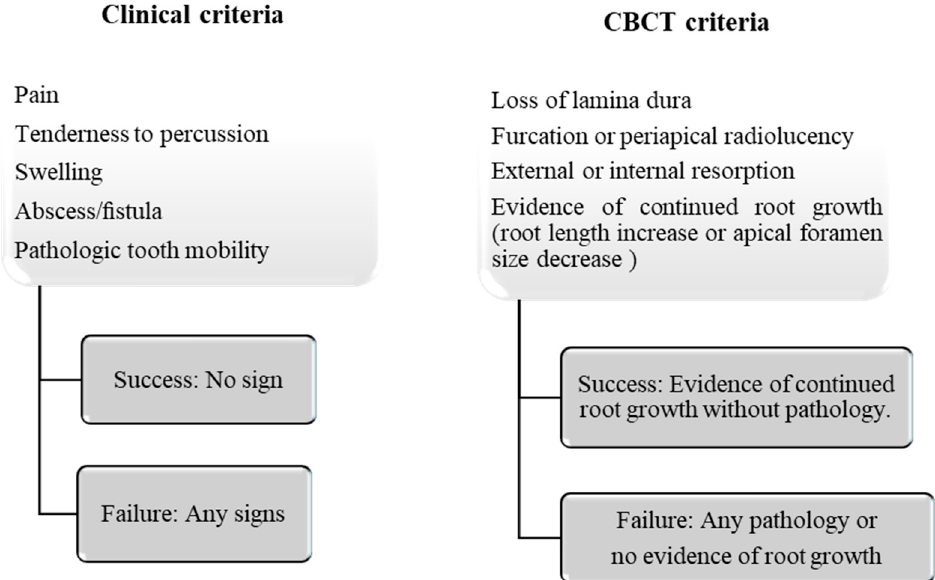
Figure A1. Outcome evaluation criteria.